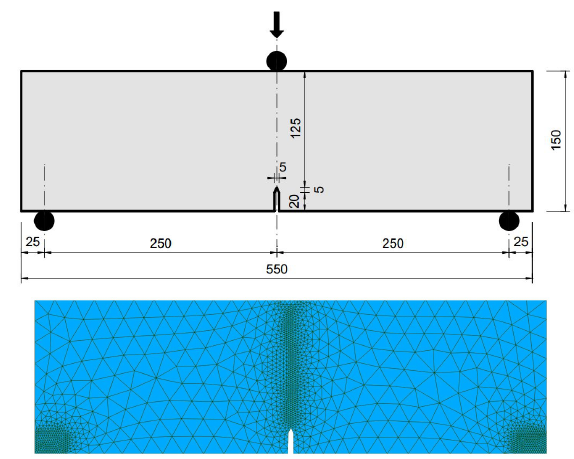
Figure 2. Geometry of FRC specimen (top) and mesh of computational model